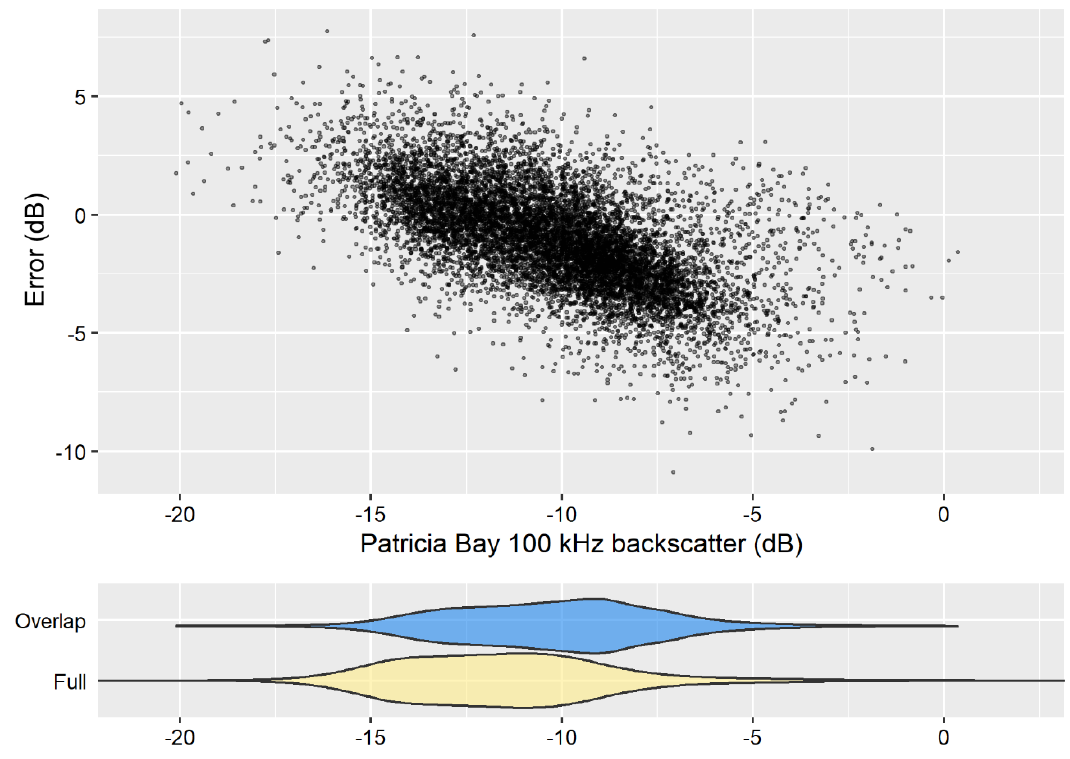
Figure 2. Error between 100 and 200 kHz Patricia Bay backscatter datasets from the area of overlap as a function of the 100 kHz signal. Violin plots show the distribution of the 100 kHz data from the area of overlap (blue), which corresponds to the error plot, compared to the full distribution of the full 100 kHz dataset (yellow).